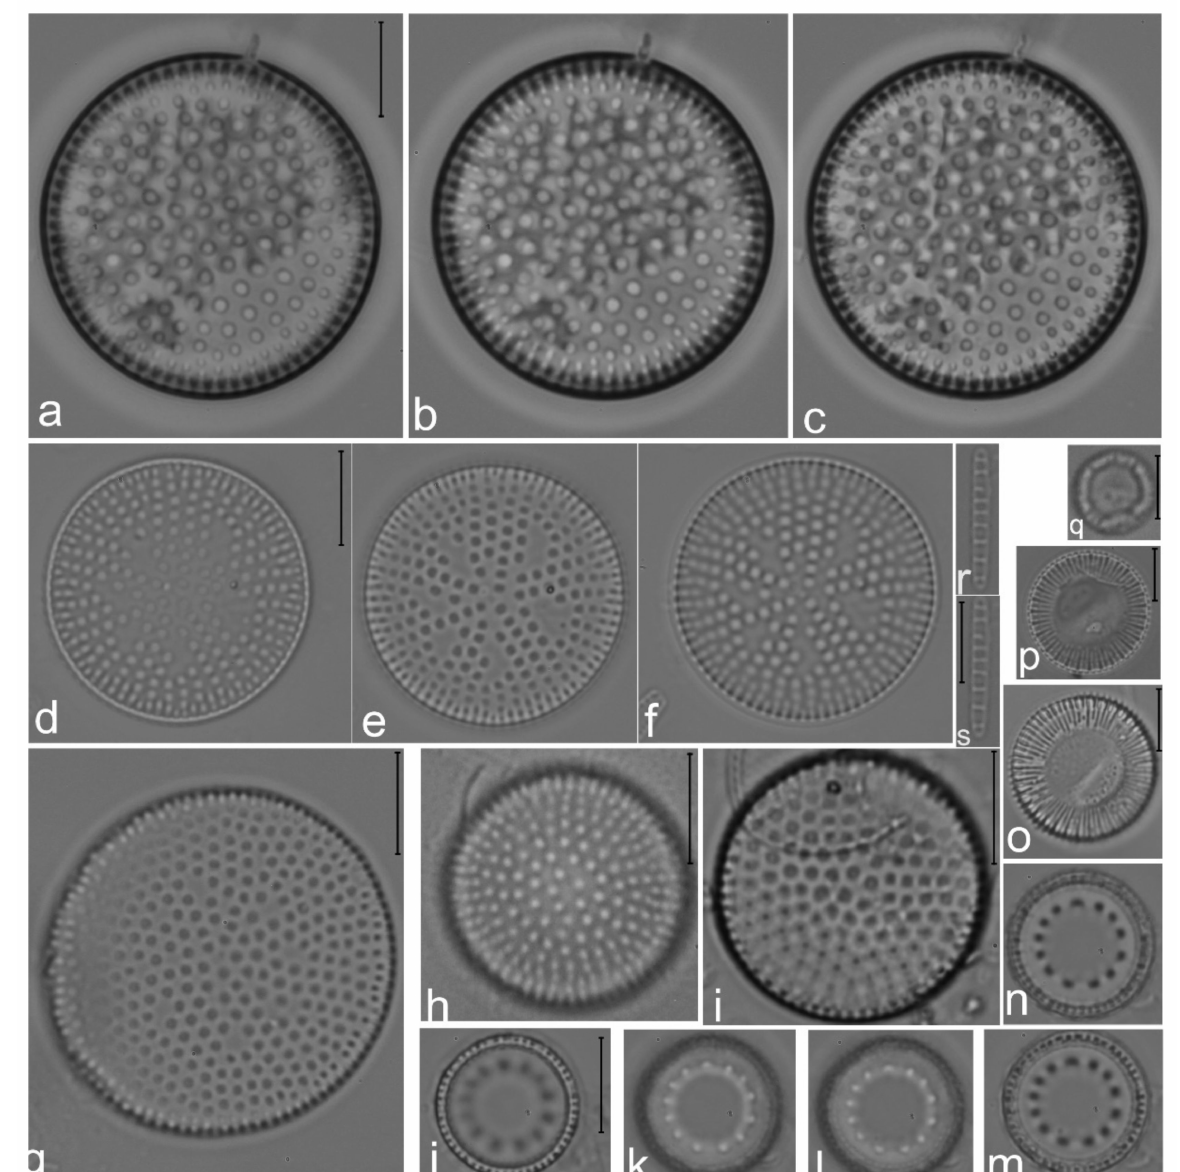
Figure 7. ( a – c , h , i ) Psammodiscus calceatus in different focal views; ( d – g ) P . nitidus valves in dif- ferent focal views; ( j – n ) Paralia sulcata valves in different focal views; ( o , p ) Cyclotella litoralis ( q ) Cyclotella atomus ; ( r , s ) Nagumoea vallus . Scale bar = 10 µ m; q = 5 µ